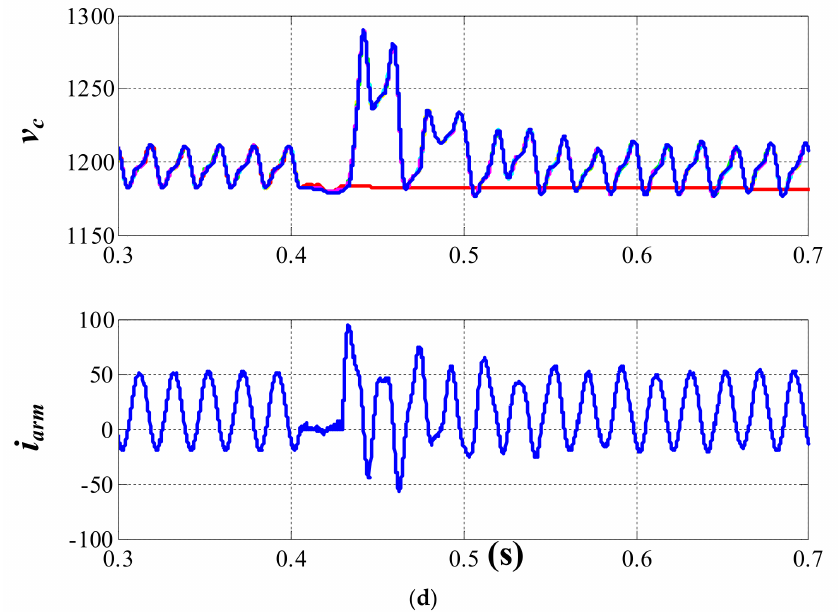
Figure 9. The fault-tolerant operation. ( a ) The output voltage, current, and circulation of the B phase upper bridge arm sub-module 4 with an S 1 open circuit fault; ( b ) The capacitance voltage and bridge arm current of the B phase upper bridge arm sub-module 4 with an S 1 open circuit fault; ( c ) The sub-module output voltage, current ,and circulation of the B phase upper bridge arm sub-module 4 with an S 2 open circuit fault; ( d ) The sub-module capacitance voltage and bridge arm current of the B phase upper bridge arm sub-module 4 with an S 2 open circuit